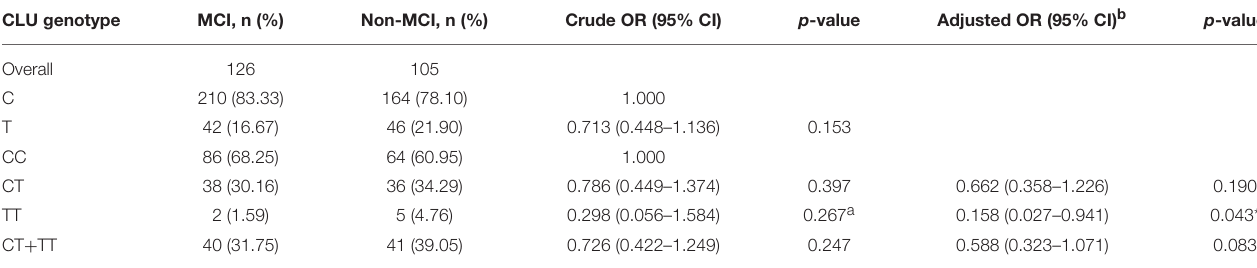
TABLE 3 | Distributions of CLU genotype and allele frequencies between groups. CLU genotype